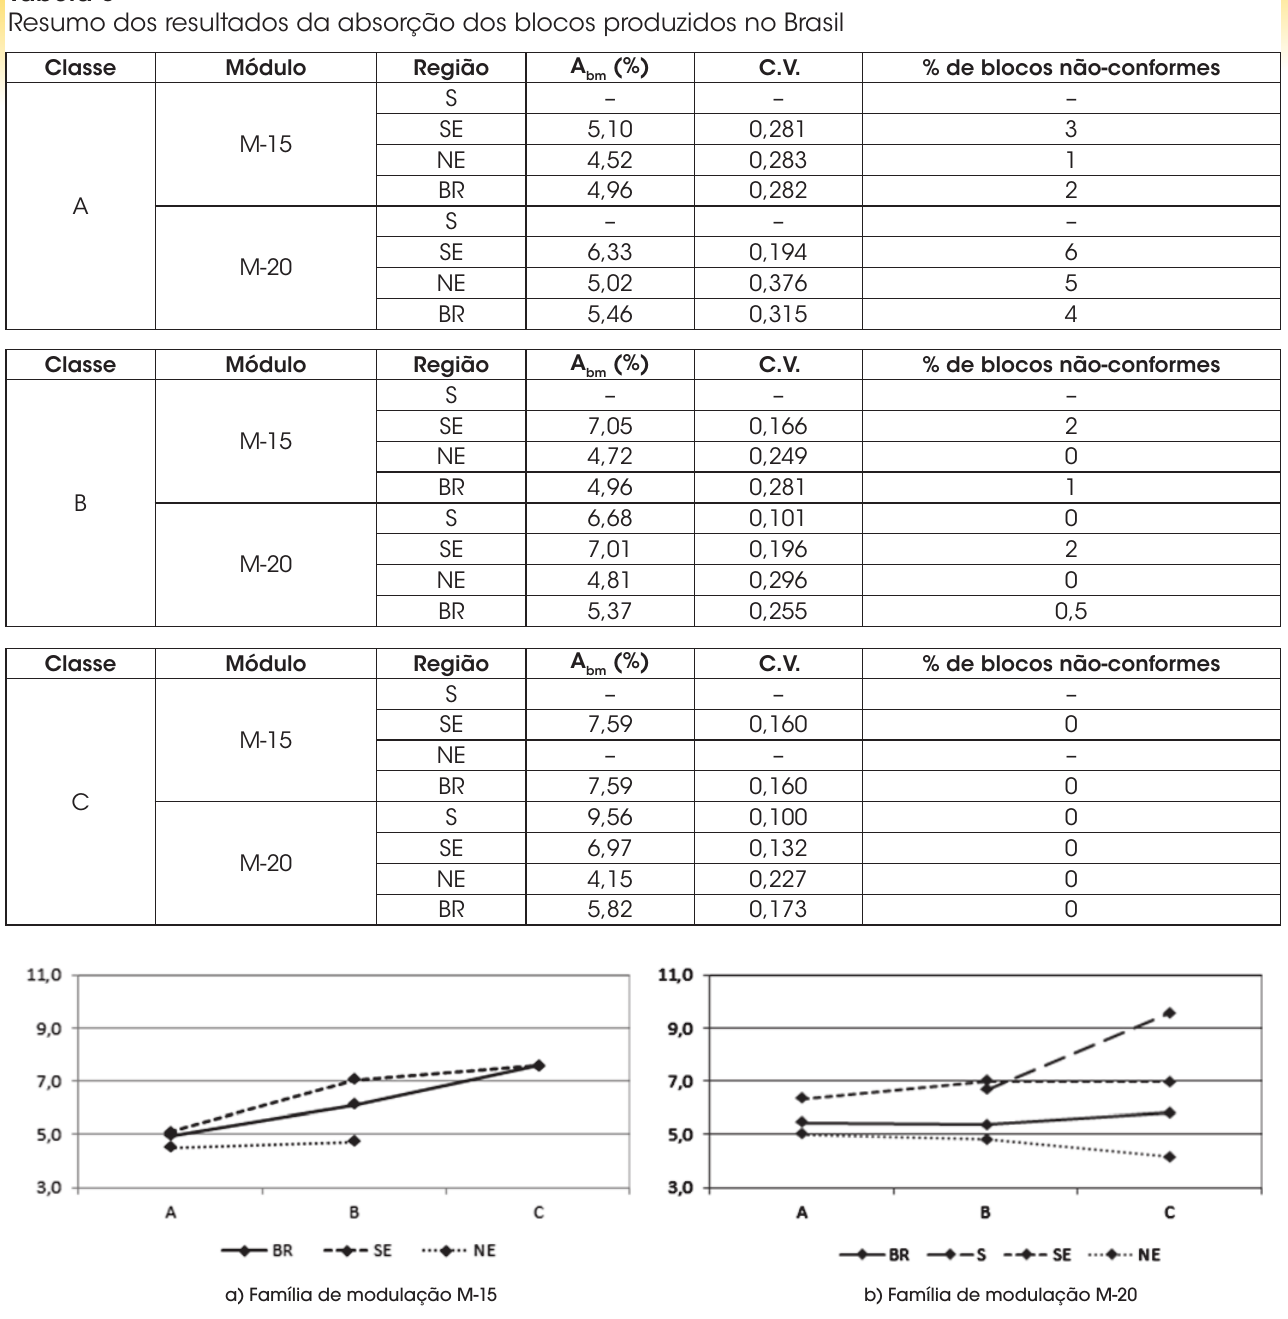
Figura 4 Absorção média (A